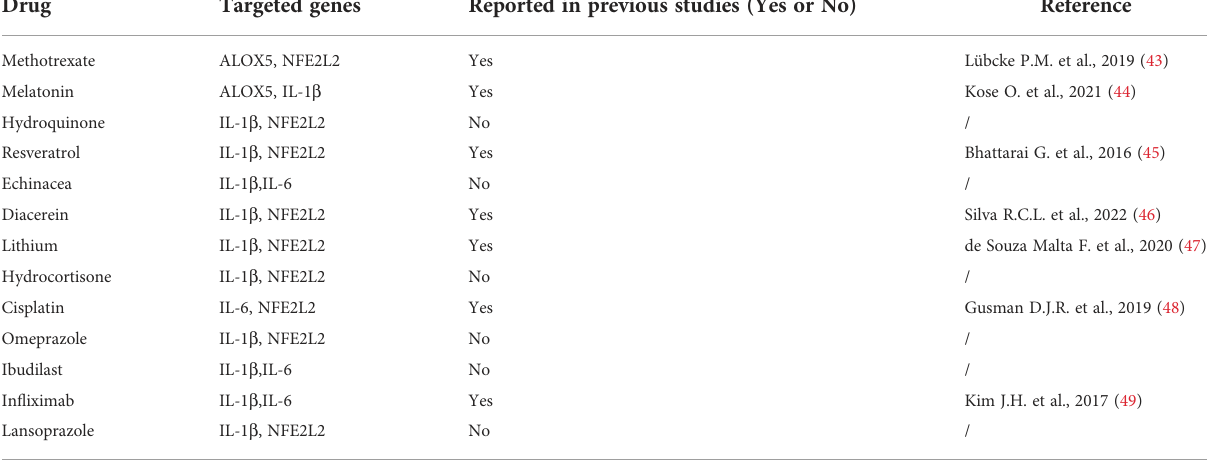
TABLE 2 Drug-gene interaction analysis and literature search. Drug Targeted genes Reported in previous studies (Yes or No)